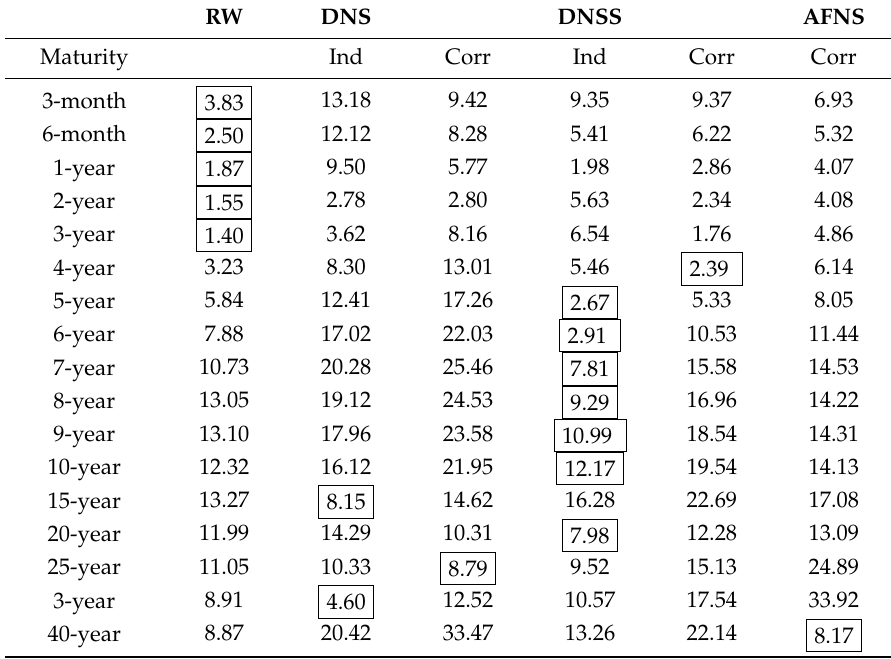
Table 6. Root mean squared forecast error of a 6-month forecast.